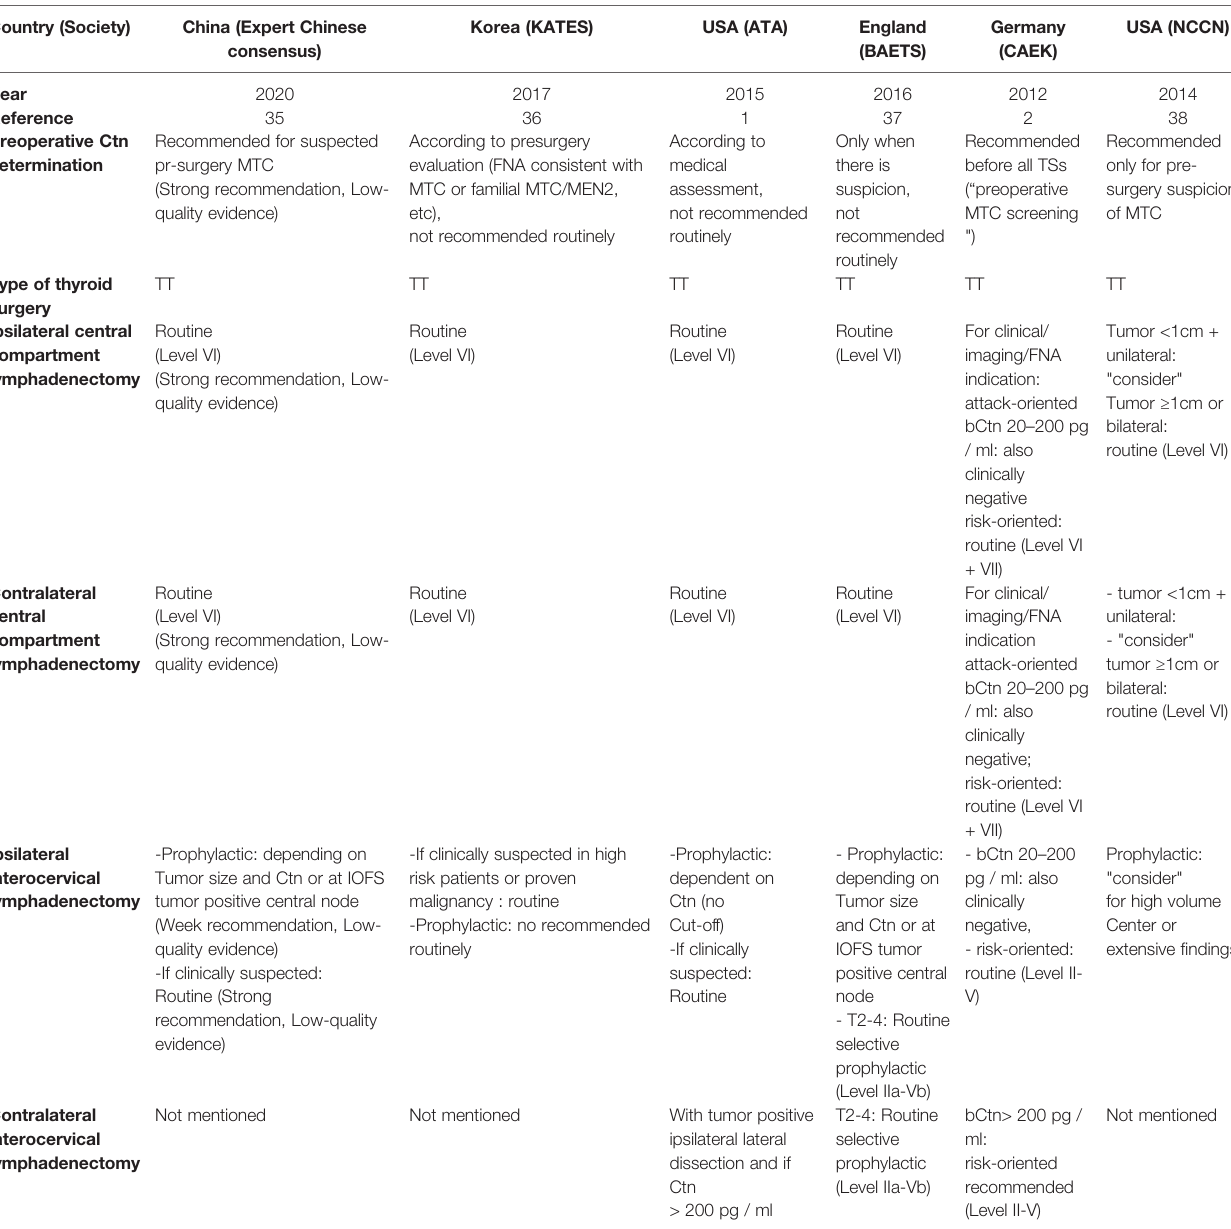
TABLE 1 | Recommendations of the major international guidelines concerning the type of surgery for the initial treatment of MTC. Country